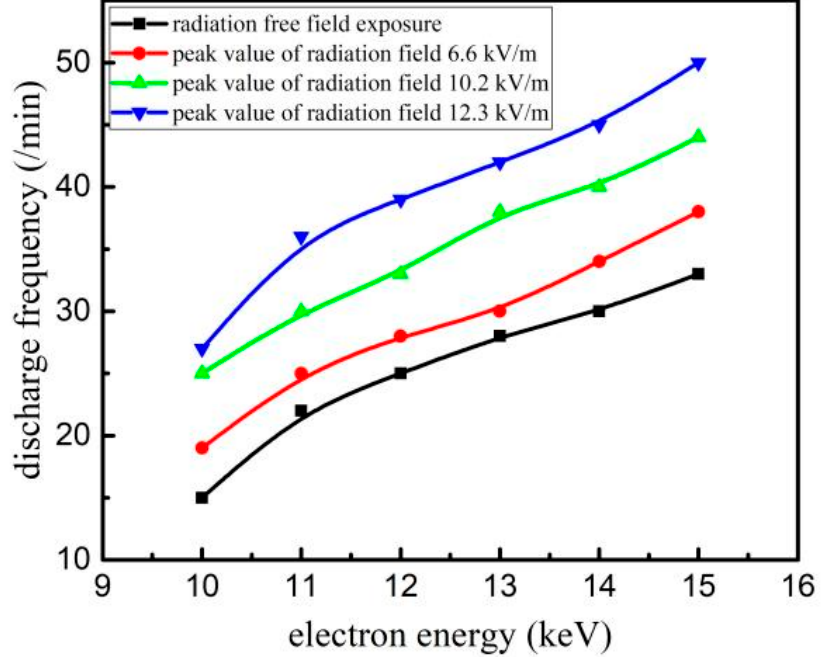
Figure 10. The change trend of discharge frequency of solar array with electron energy.